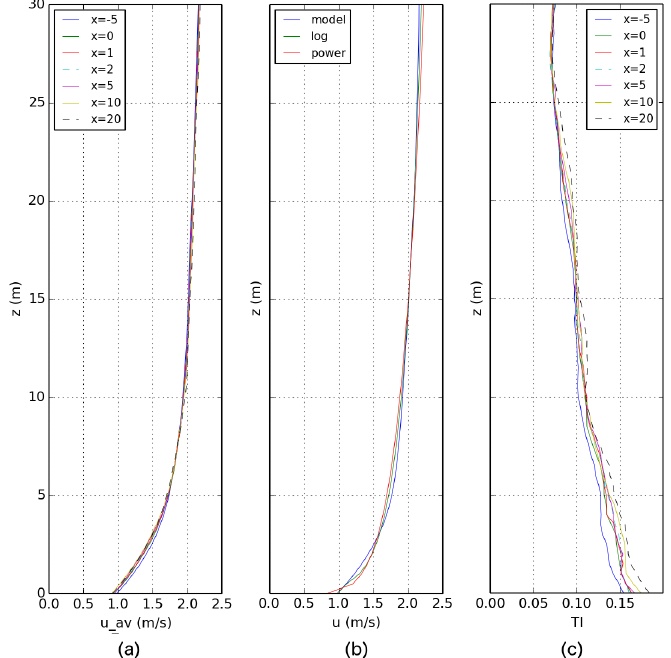
Figure 4. Turbulent flow in an empty rectilinear channel, showing vertical profiles for ( a ) time-averaged velocity magnitude; ( b ) spatially-averaged velocity magnitude versus ideal log and power law profiles and ( c ) calculated turbulent intensity. Units for x are in D, the diameter of the turbine rotors (16 m). x = 0 is where turbine rotors are to be placed, 250 m downstream of the